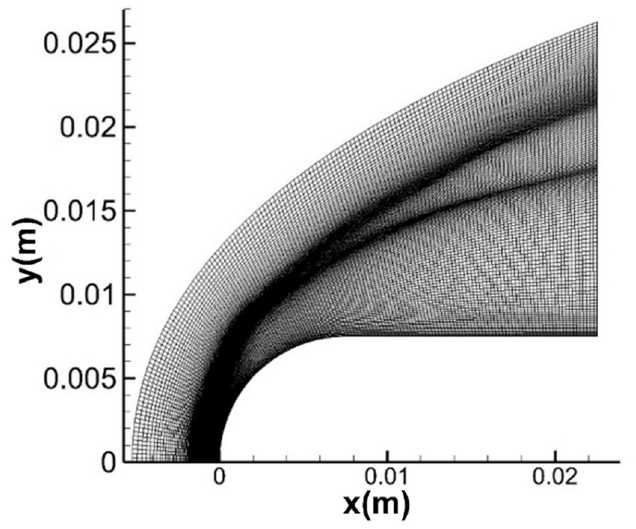
Figure 15. Structured mesh for shock-induced super-detonative combustion calculation. Table 8. Flow conditions of super-detonative combustion.